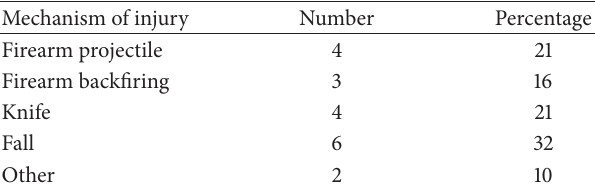
Table 1: Mechanisms of